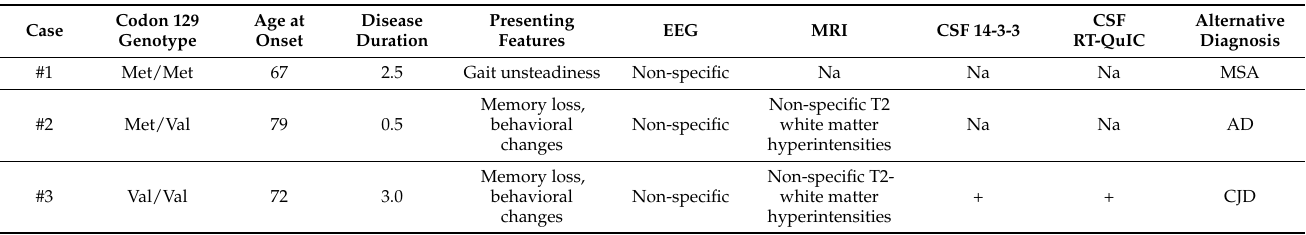
Table 1. Main clinical findings in VPSPr